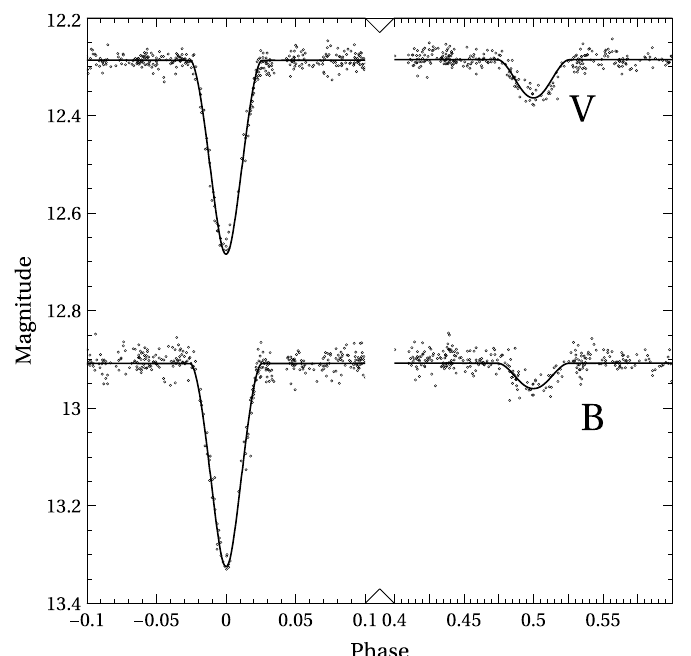
Figure 1. Observed and computed light curves around the eclipses of GSC 2945:01857 in the B and V passbands.